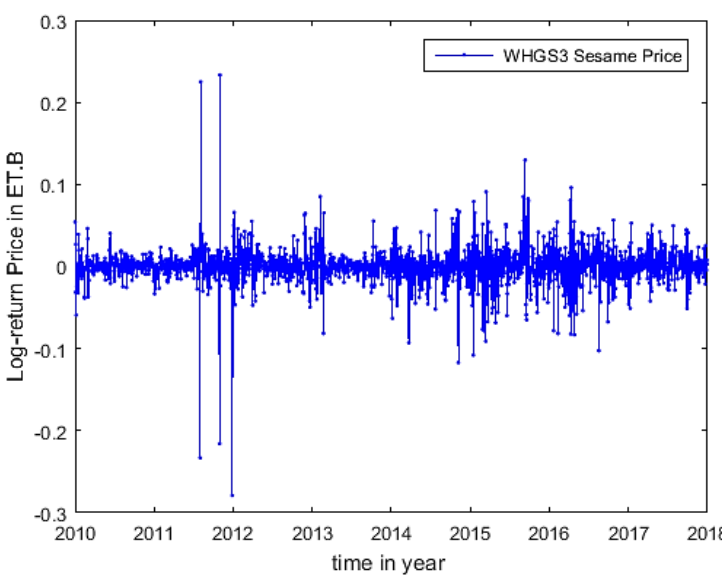
Figure 2. Log-return WHGS3 sesame price from 2010 to 2018.